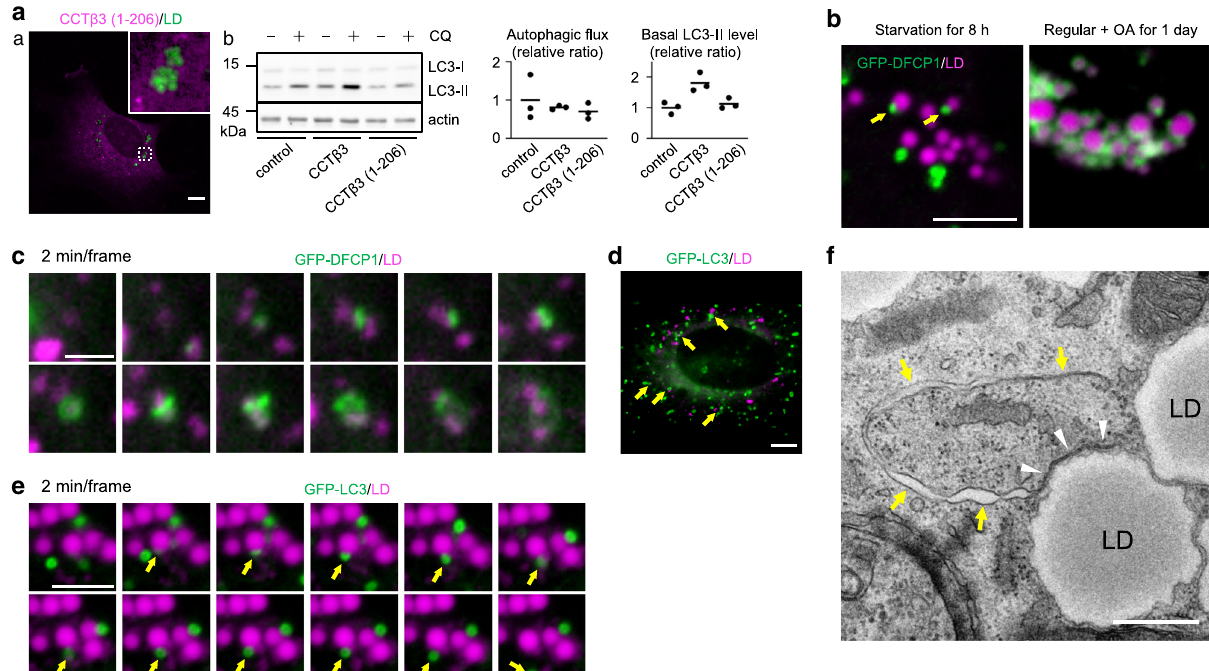
Fig. 6 Autophagic membranes and LDs. a Distribution and effects of CCT β 3(1-206)-mCherry expression in MEFs starved for 8 h. (a) Distribution of CCT β 3(1-206)-mCherry (magenta) and LDs (green). Bar, 10 μ m. (b) Western blotting of LC3. MEFs overexpressing CCT β 3 or CCT β 3(1-206) were compared with untransfected MEFs. A representative result of three independent experiments. b Distribution of GFP-DFCP1 (green) and LDs (magenta) in MEFs starved for 8 h (left) and in MEFs cultured in OA-containing regular medium for 1 day (right). GFP-DFCP1 puncta in starved MEFs are marked by arrows. Bar, 5 μ m. c Expansion of the omegasome (green, GFP-DFCP1) around LDs (magenta) in MEFs starved for 8 h. Selected images from Supplementary Movie 1. Bar, 2 μ m. d Distribution of GFP-LC3 (green) and LDs (magenta) in MEFs starved for 8 h. Bar, 10 μ m. e Emergence of isolation membranes/autophagosomes (green, GFP-LC3; arrows) around LDs (magenta) in MEFs starved for 36 h. Selected images from Supplementary Movie 2. Bar, 5 μ m. f EM of MEFs overexpressing CCT β 3 starved for 8 h. The isolation membrane (arrows) adheres to the LD surface (arrowheads). Bar, 0.5 μ m. Source data are provided as a Source data fi